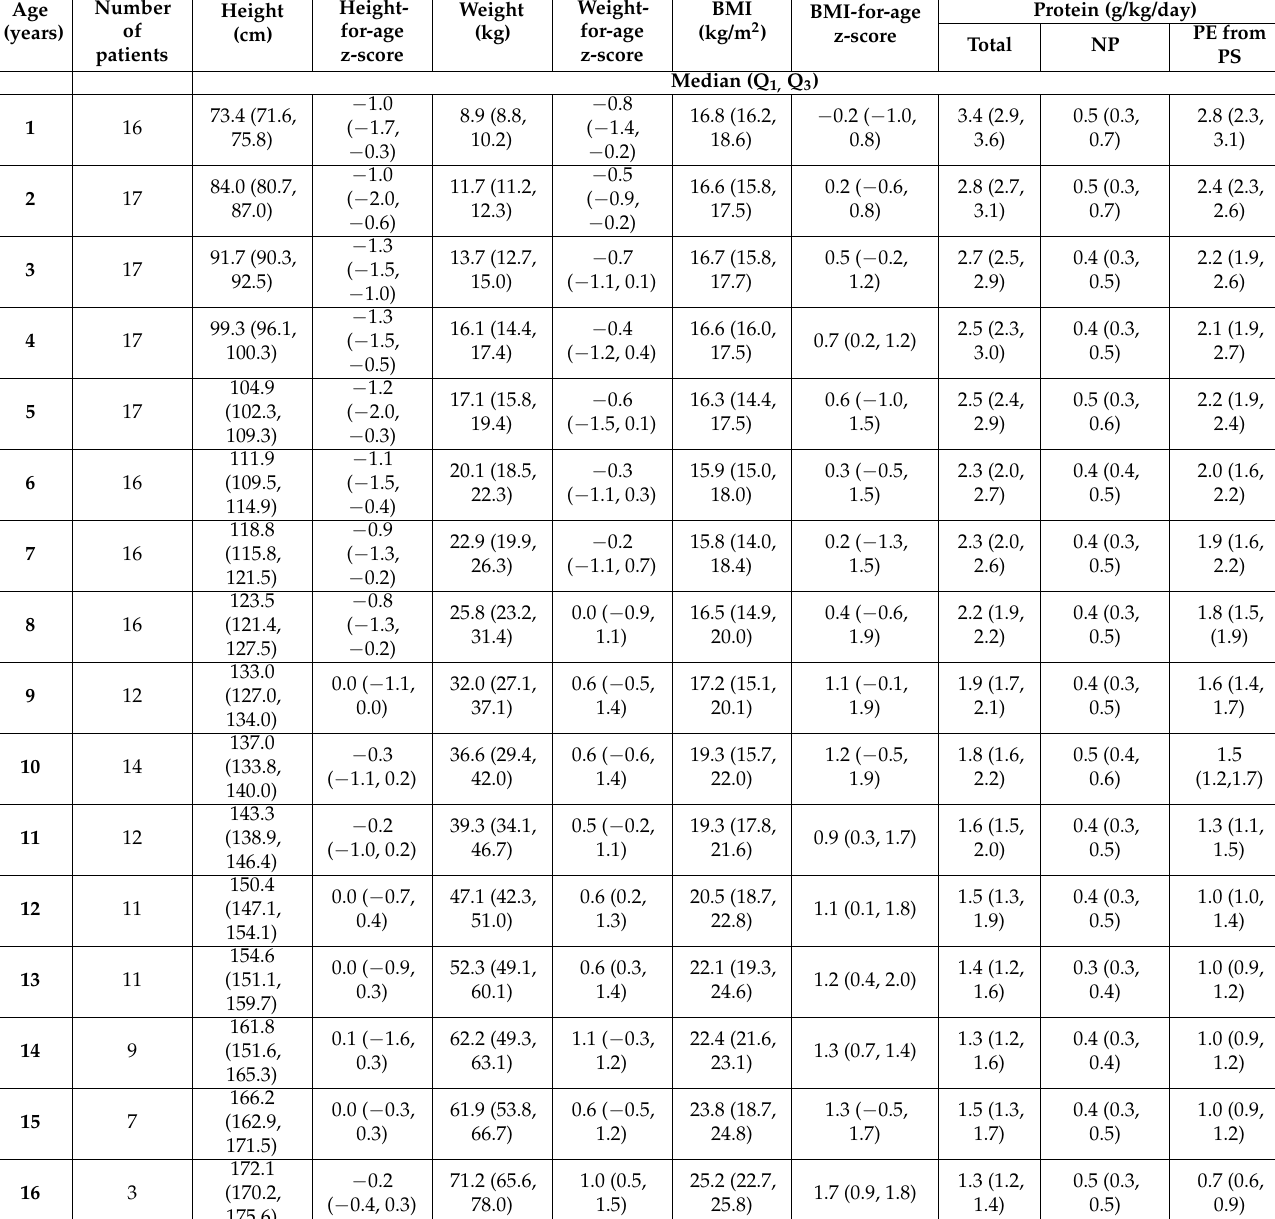
Table 2. Anthropometric characteristics and prescribed total protein, natural protein and protein equivalent intake from protein substitutes by